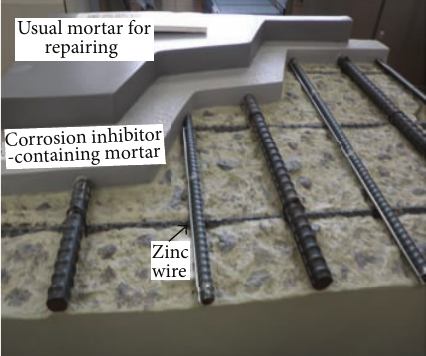
Figure 14: Model of details of the combined corrosion protection technique.